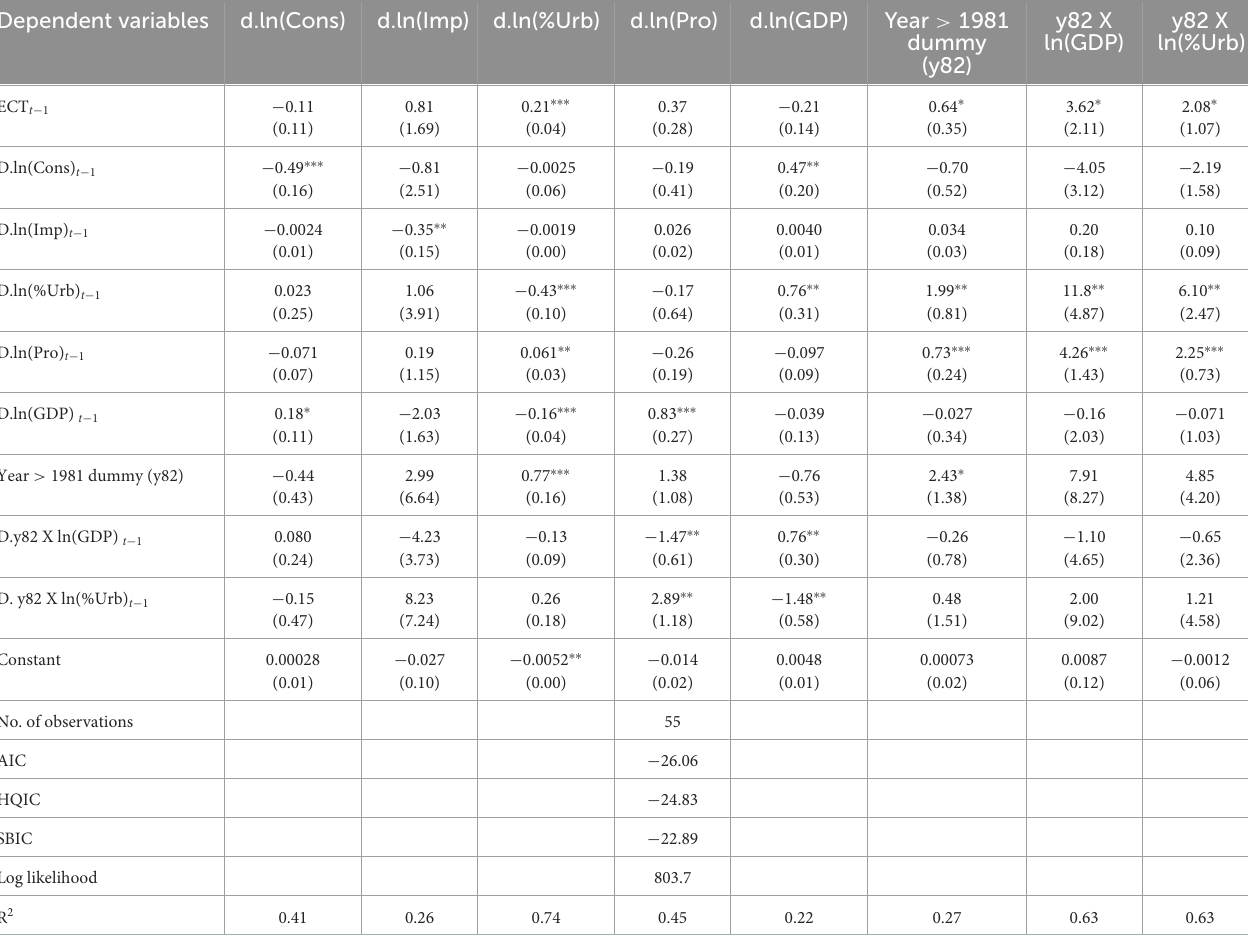
TABLE 4 Estimated functions applying the Vector Error Correction (VEC) model estimation procedure, explaining the relationship between yearly per capita wheat consumption, wheat import, % share of the urban population, domestic wheat production, and GDP per capita in China. Dependent